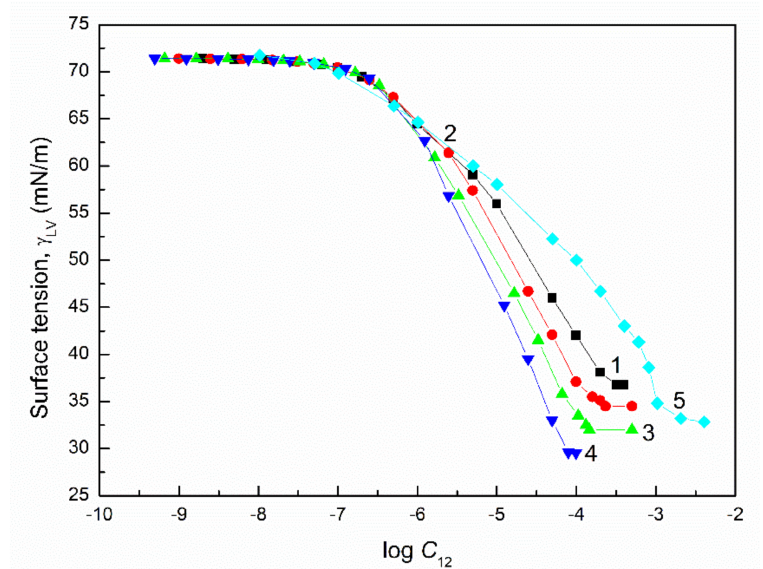
Figure 6. A plot of the surface tension ( γ LV ) of the aqueous solution of the RL and TX165 mixture vs. the logarithm of its concentration ( C 12 ). Curves 1 − 4 correspond to the RL mole fractions in the mixture equal to 0.2, 0.4, 0.6, and 0.8, respectively. Curve 5 corresponds to the sum of the RL and TX165 concentrations, where the TX165 concentration changed from 0 to 0.004 mole/dm 3 and the RL concentration changed from 3.97 × 10 − 10 to 7.94 × 10 − 5 mole/dm 3 , as applied in the literature [22,24] for their aqueous solution surface tension measurements.